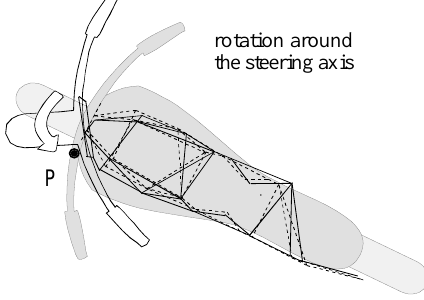
Fig. 6. Vehicle A, TDM, frequency 15.6 Hz, hysteretic damping 9.5%.